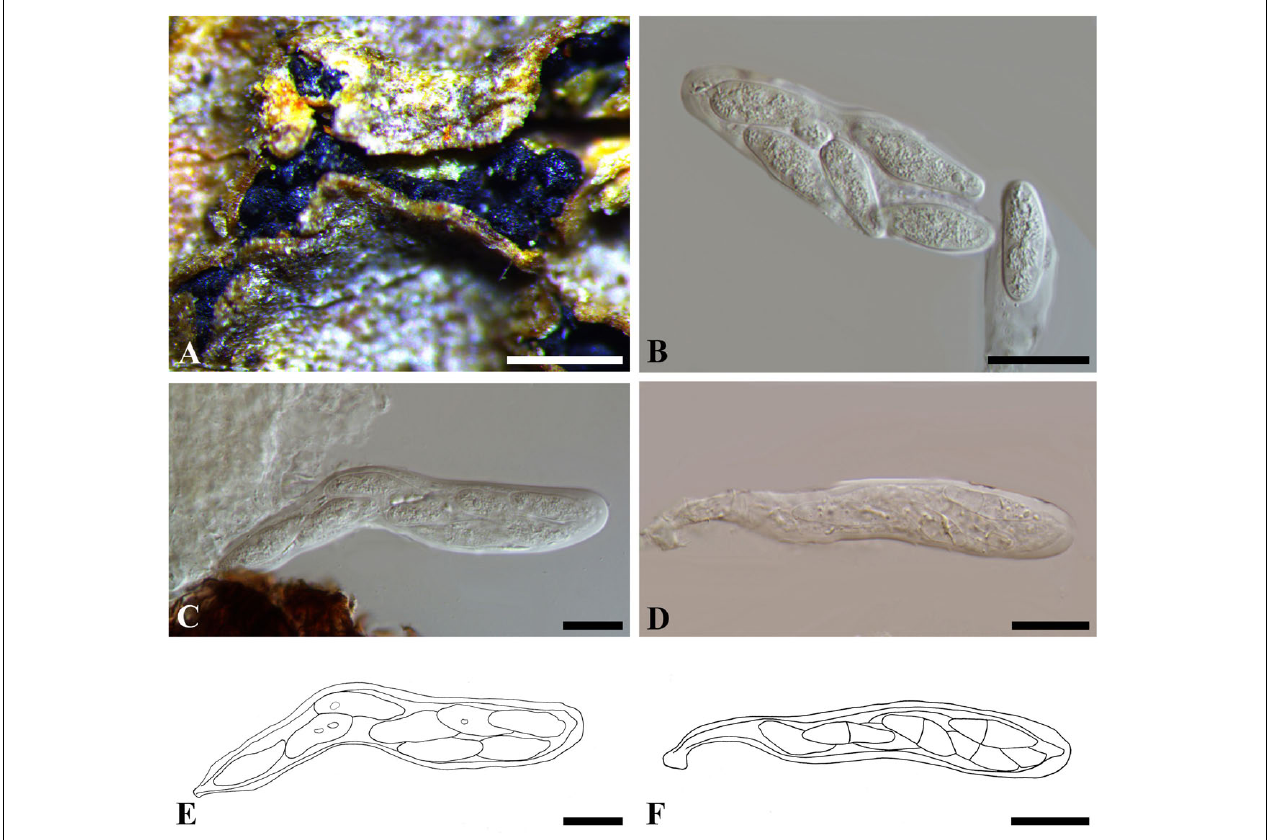
FIGURE 10 | Botryosphaeria wisteriae (MICH 15081, isotype ). (A) Botryose clustered ascomata erumpent through a twig epidermis. (B) Broken ascus showing hyaline, narrowly fusiform, ascospores within it. (C-F) Clavate ascus with aseptate or separated ascospores. Scale bars: (A) = 500 µ m, (B-F) = 10 µ